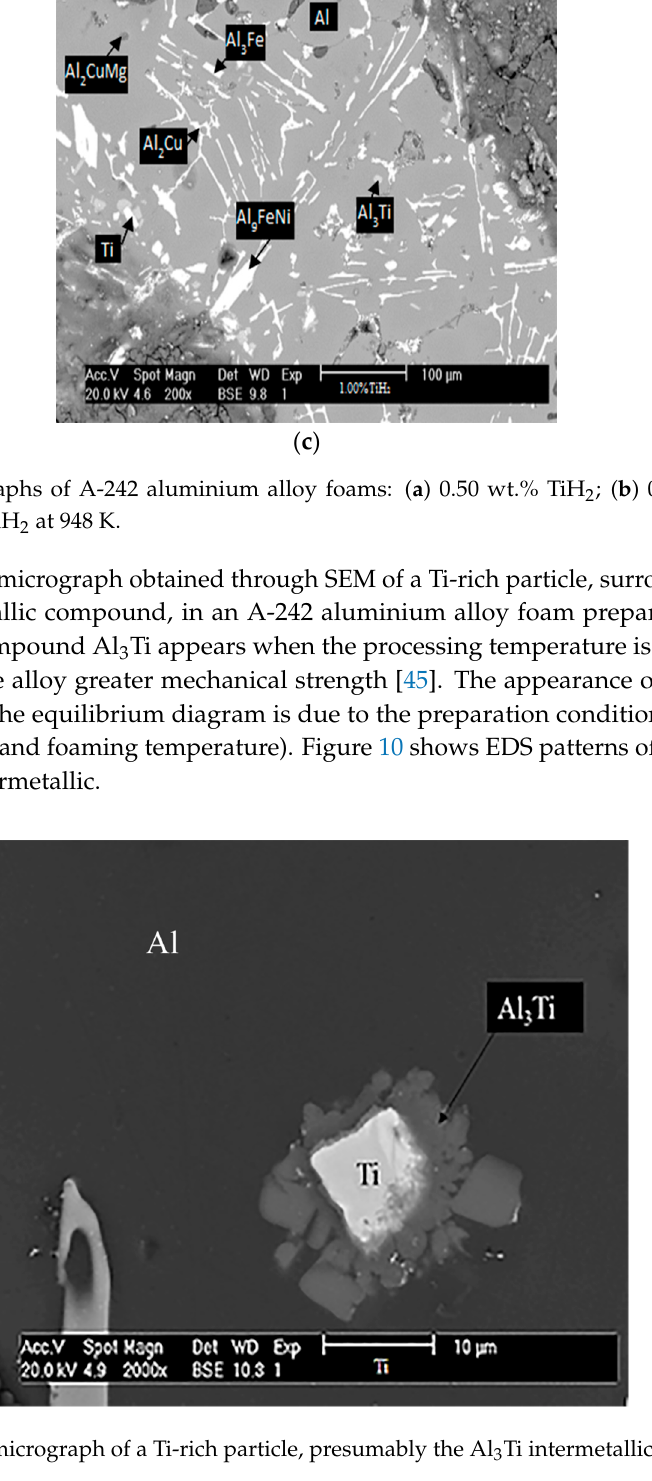
Figure 10. Energy dispersion spectroscopy (EDS) patterns for the Ti-rich particle. 4. Conclusions From the results obtained in this work, it is important to emphasize the possibility of using secondary aluminium for the preparation of aluminium alloy foams with characteristics similar to those obtained by the use of commercial-purity elements. Aluminium alloy foams were prepared with closed porosity in the order of 88.22% and with a relative density of 0.12. The pore size was 1.29 mm, and the wall thickness was 114.67 μ m. Various intermetallic compounds were identified scattered on the pore walls, such as Al 2 Cu, Al 9 FeNi, Al 3 Fe, Al 2 CuMg, Ti, and Al 3 Ti. The aluminium alloy foams manufactured with 1.00 wt.% TiH 2 showed higher concentrations of intermetallics.